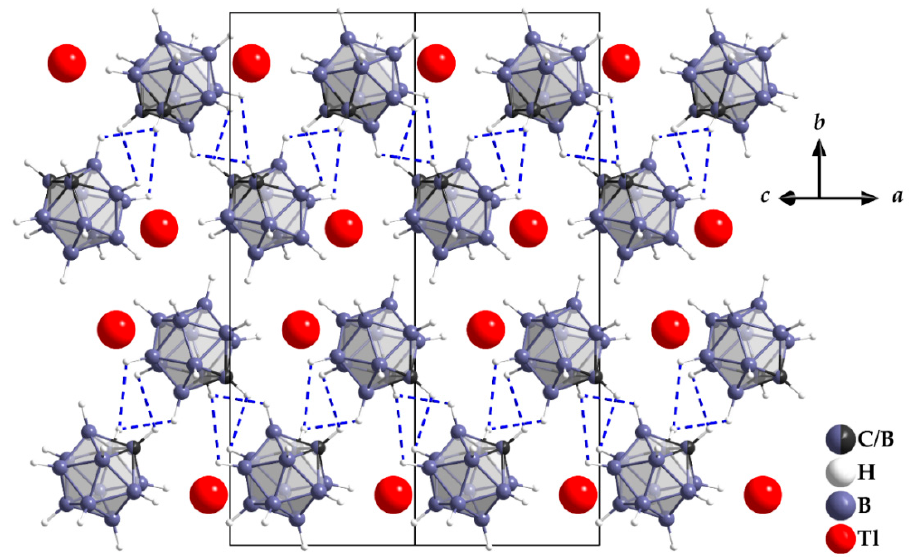
Figure 5. Representation of two extended unit cells of Tl[CB 11 H 12 ] along [101] with highlighted electrostatic C δ − –H δ + ··· δ − H–B δ + interactions.